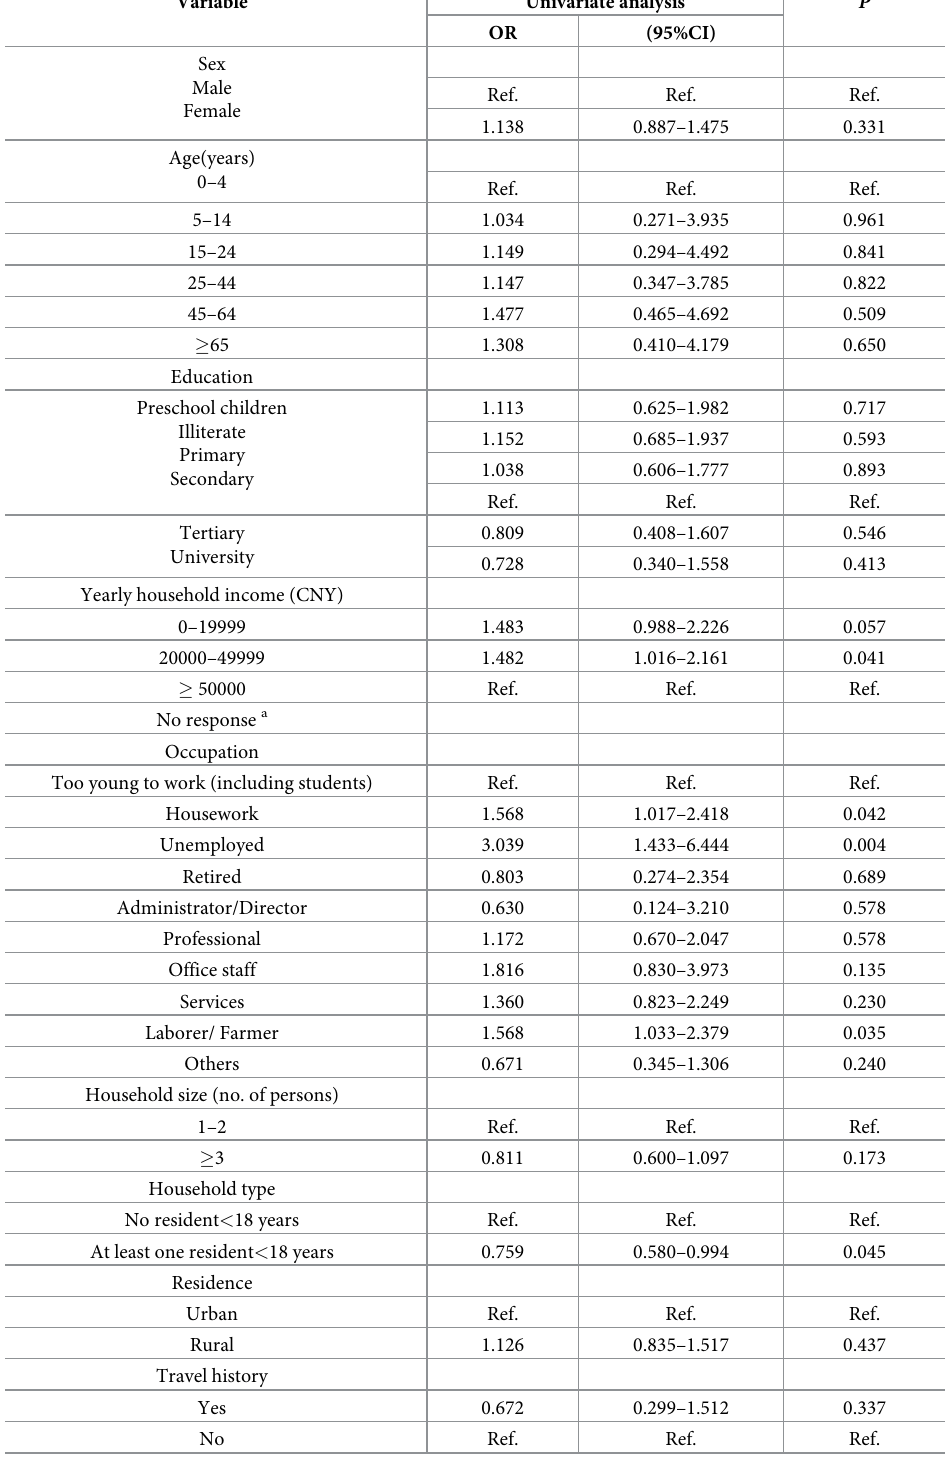
Table 2. Univariate analysis of the relationship between demographic characteristics and acute gastrointestinal illness in the 4 weeks prior to interview in Zhejiang Province, July 2018-June